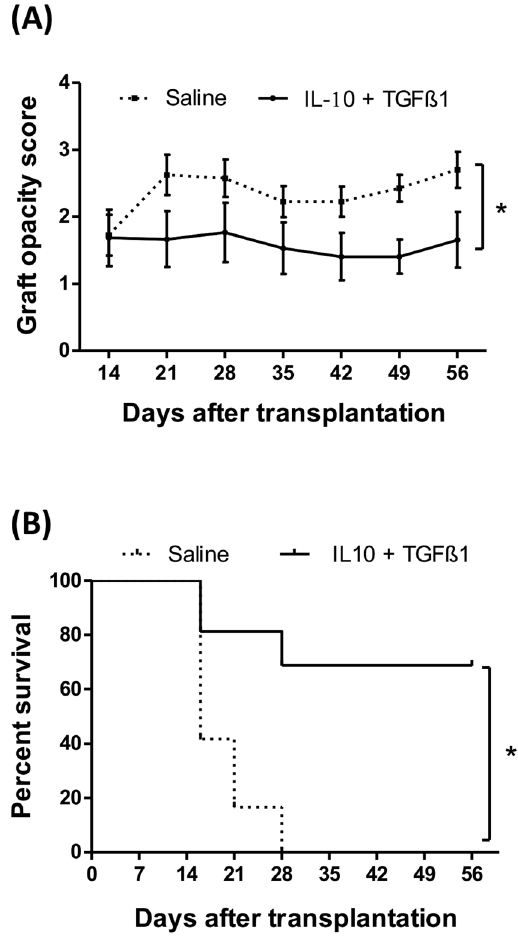
Figure 4. Treatment of donor corneas with IL-10 and TGF β 1 increases corneal allograft survival. Donor corneas received a single subconjunctival injection of IL-10/TGF β 1 or saline (control) two days prior to grafting. Corneal transplantation (N = 10–16/group) was performed onto inflamed graft beds. Weekly examination of grafts until 8 weeks post-transplantation revealed ( A ) decreased graft opacity scores (p = 0.0011) and ( B ) increased graft survival in IL-10/TGF β 1-treated grafts compared to saline-treated controls (68.7% vs. 0%, p < 0.0001). Error bars show standard error of